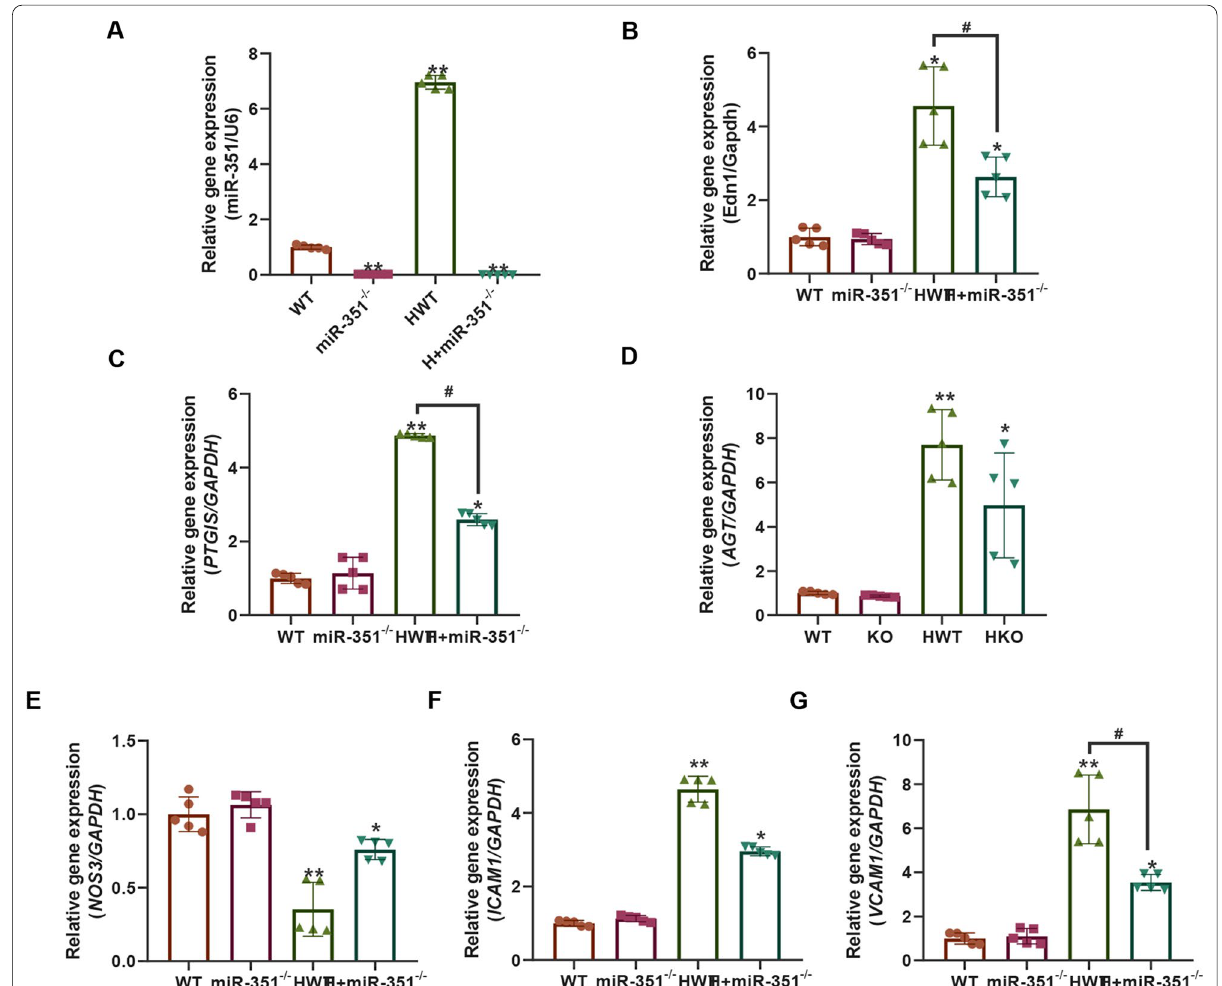
Fig. 3 qPCR detection results. A MiR-351 gene expression level in the serum of each group of mice; B – G Relative expression levels of the EDN1 , PTGIS , AGT, NOS3 , ICAM1 and VCAM1 genes in the aorta of each group. N represents the comparison between the two groups of